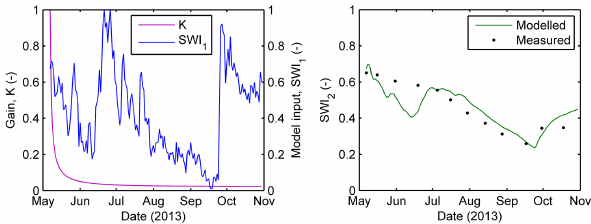
Figure 9. Input and output signals of the exponential filter using the optimized parameters from Table 1. SWI 1 is the soil water index of the cosmic-ray neutron probe